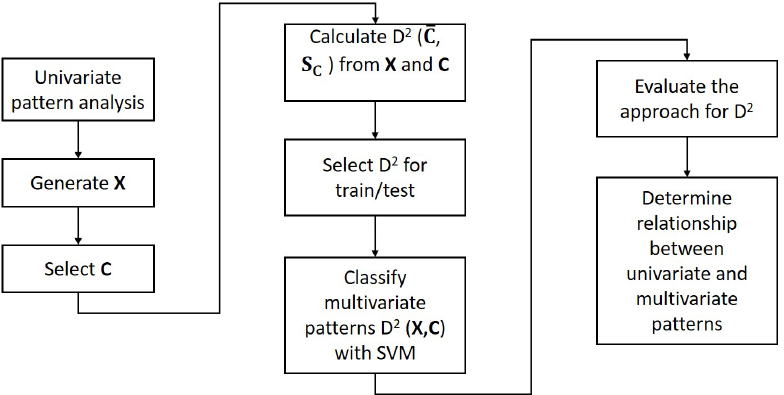
Figure 2. Research method for a process or system of interest, where C is the variable with stable behaviour and X is the variable under